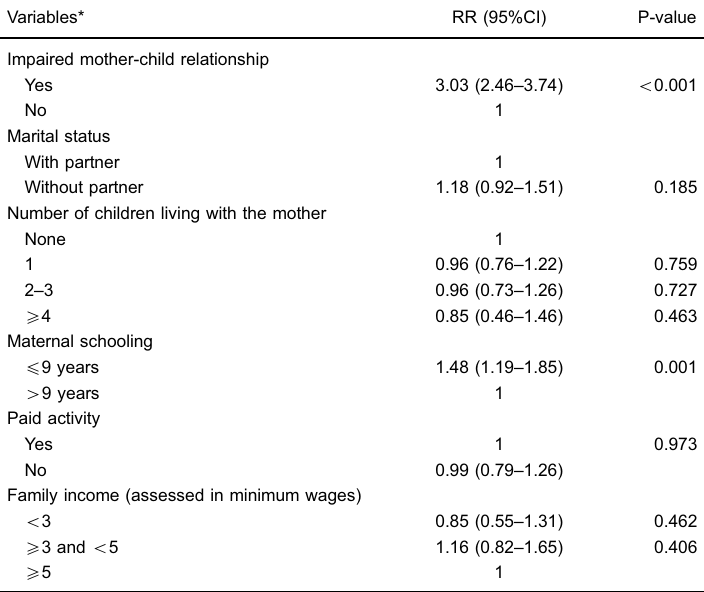
Table 2. Adjusted logistic regression analysis of the association between maternal psychological distress and impaired mother-child relationship, from the BRISA Study, São Luís,